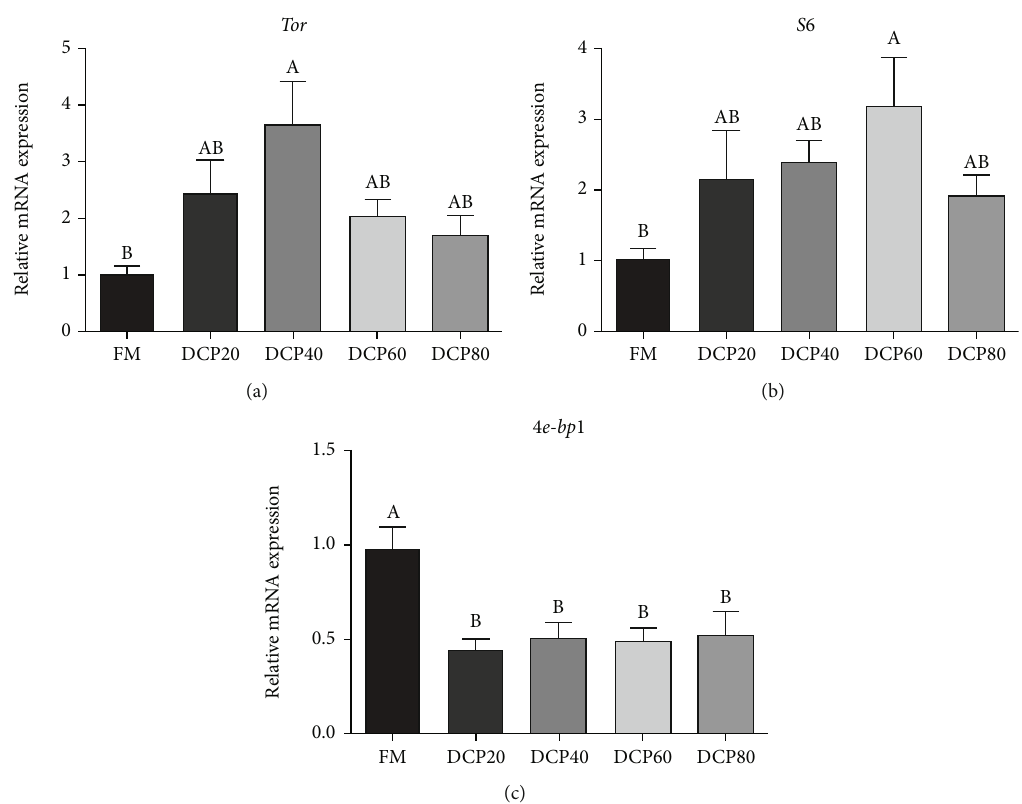
Figure 7: Relative expression of genes related to the TOR pathway of juvenile fed the trial diets ( means ± SEM, n = 3 ). tor : target of rapamycin; s6 : ribosomal protein S6; 4e-bp1 : eukaryotic initiation factor4E binding protein 1. No repetition of letters in the equal index means signi fi cant di ff erences ( P < 0 : 05